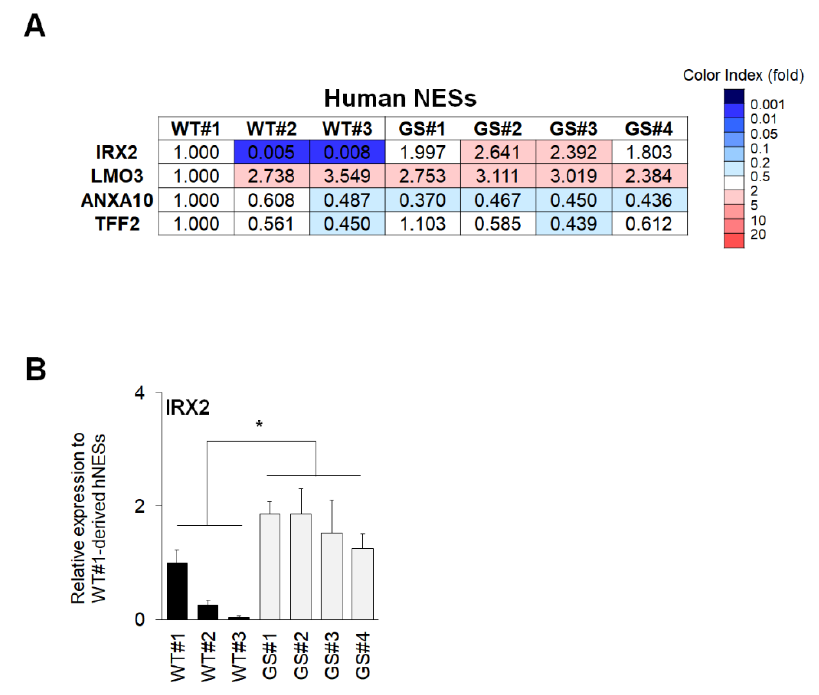
Figure 4. Verification of intestine-based four common factors in human neuroectodermal spheres (NESs). ( A ) Microarray data of commonly regulated genes in human NESs from a previous study. ( B ) qRT-PCR confirmation of IRX2 (WT, 0.4329 ± 0.2898, n = 3; GS, 1.628 ± 0.1466, n = 4, p -value 0.0103) expression in human NESs. Data are mean ± standard error of means (SEM) of at least three independent experiments. p -values were analyzed using the unpaired two-tailed Student’s t -test (* p < 0.05).